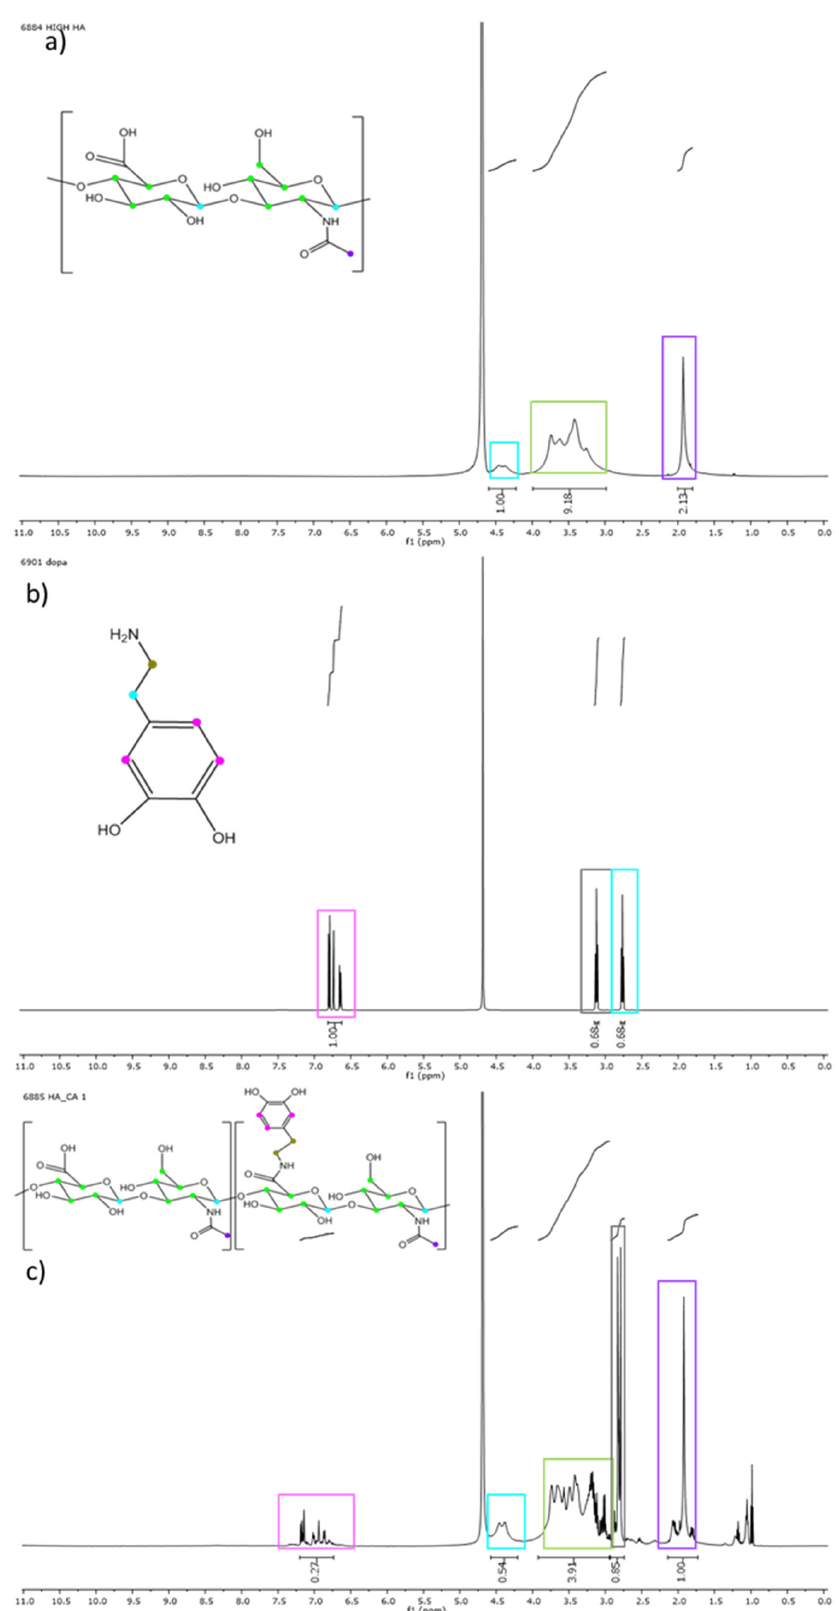
Figure 6. ( a ) High molecular weight hyaluronic acid spectrum. ( b ) Dopamine hydrochloride spec- trum, a reagent that adds catechol to the product. ( c ) Hyaluronic acid modified with catechol (HA- CA) spectrum. 1 H-NMR Hyaluronic acid (D 2 O, 500 MHz, 20 °C): δ (ppm) = 4.30 (s, 2H, anomeric CH), 3.00–4.00 (m, 10H, ring CH and CH 2 ), 1.99 (s, 3H, acetamide).